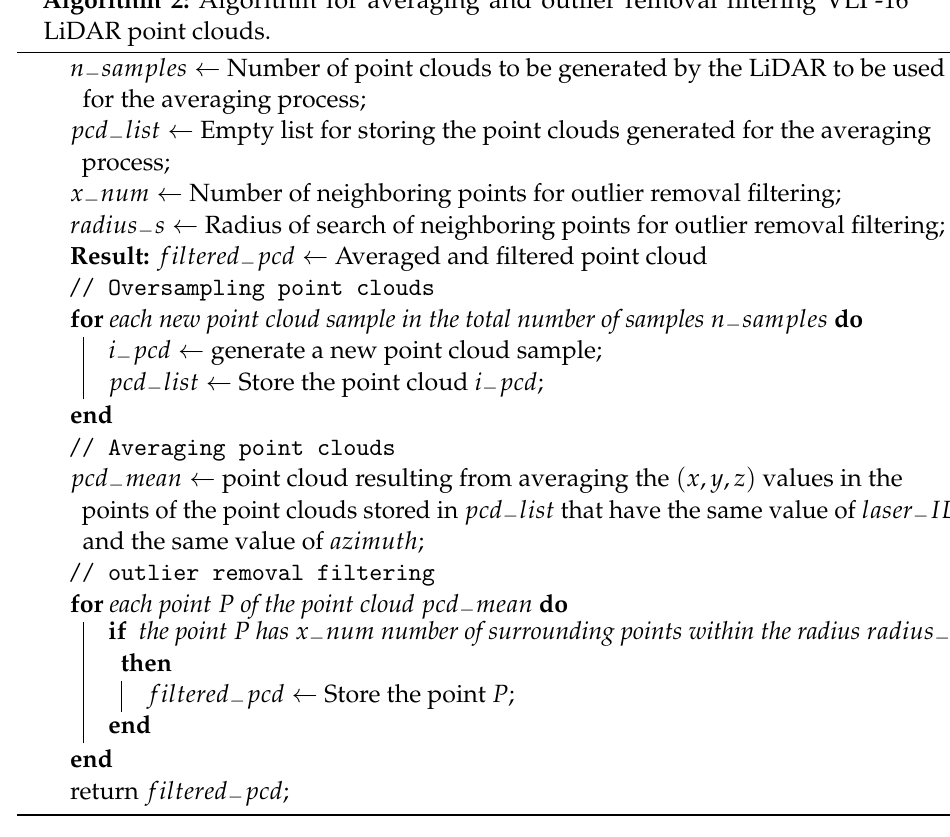
Figure 7. Point cloud oversampling and filtering diagram. Algorithm 2: Algorithm for averaging and outlier removal filtering VLP-16 LiDAR point